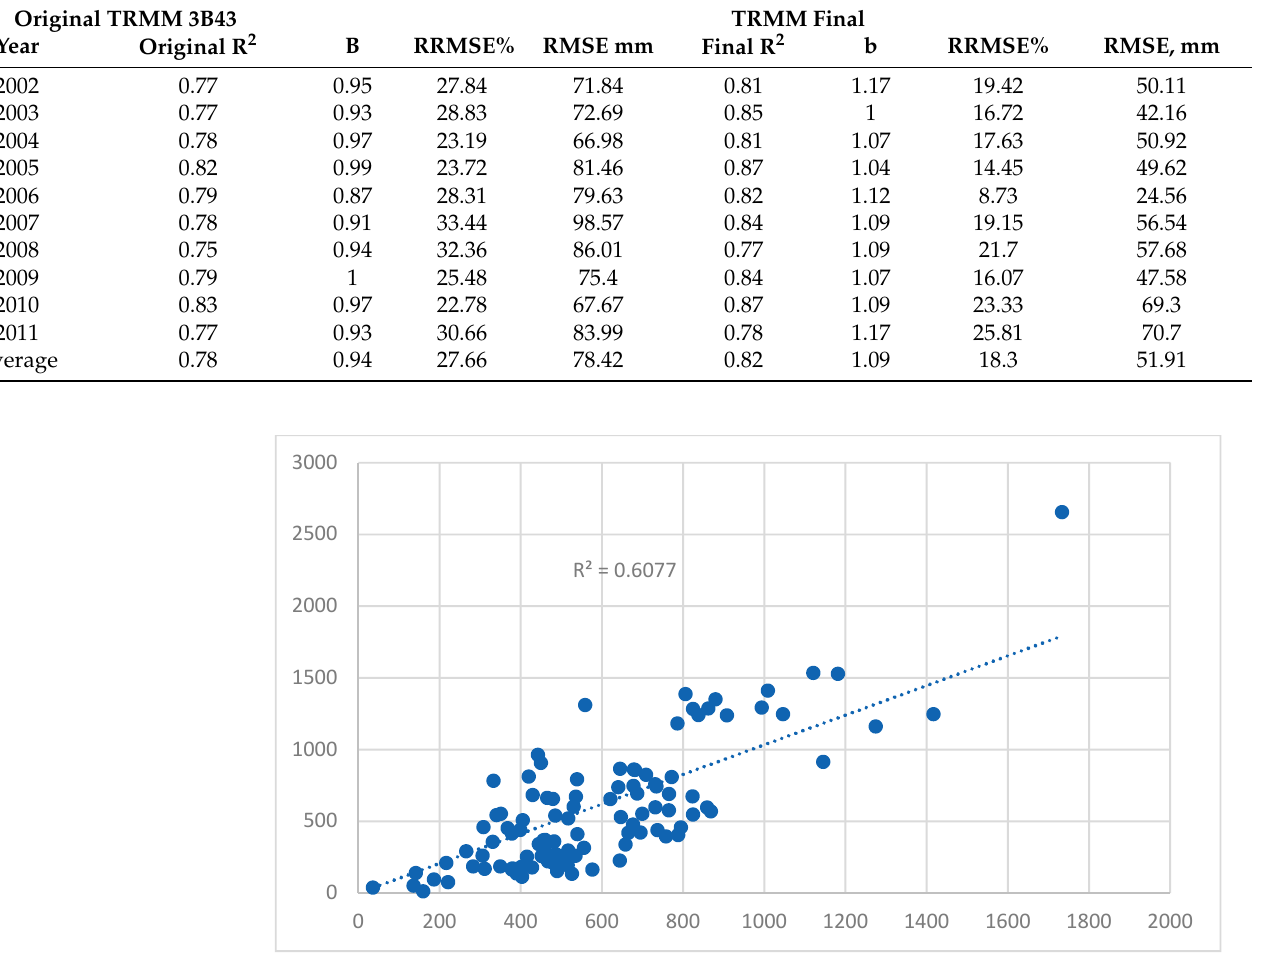
Figure 3. Correlation between downscaled TRMM base on NDVI and rain gauges.